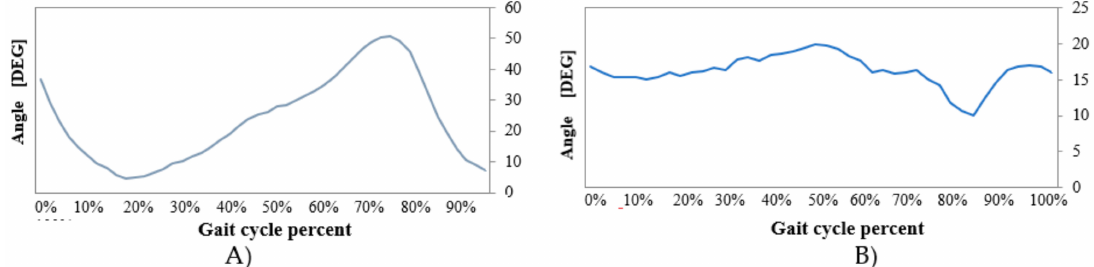
Figure 14. Analysis of knee flexion in the gait cycle using the Tracker ® software. ( A ) Flexion angles of the knee joint. ( B ) Flexion angles of the ankle